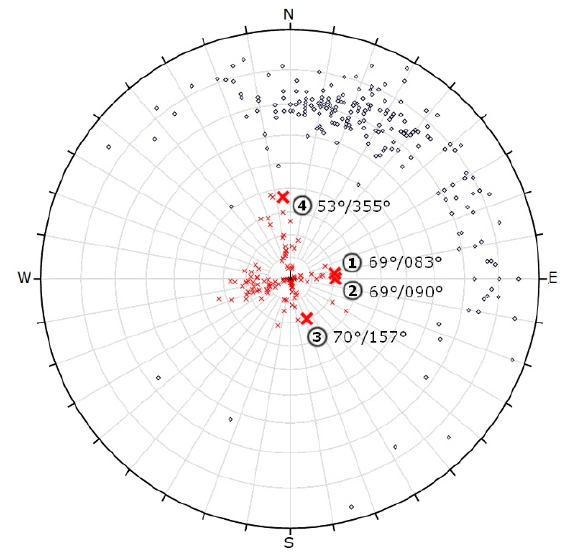
Figure 11. Stereographic projection of discontinuities using equal angle projection to the lower hemisphere with dip vectors and polar stereonet (x ~ fault, o ~ bedding). The four major faults are numbered: 1–4.